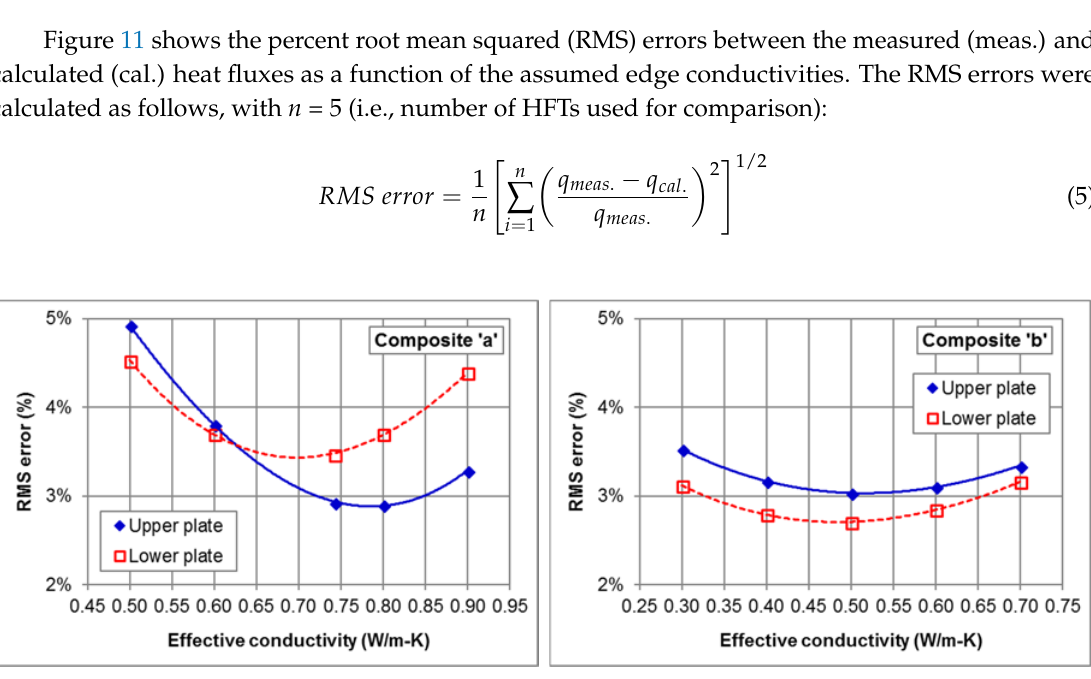
Table 2. Average measured heat fluxes from composite ‘a’ and ‘b’ used for estimating effective edge conductivities.